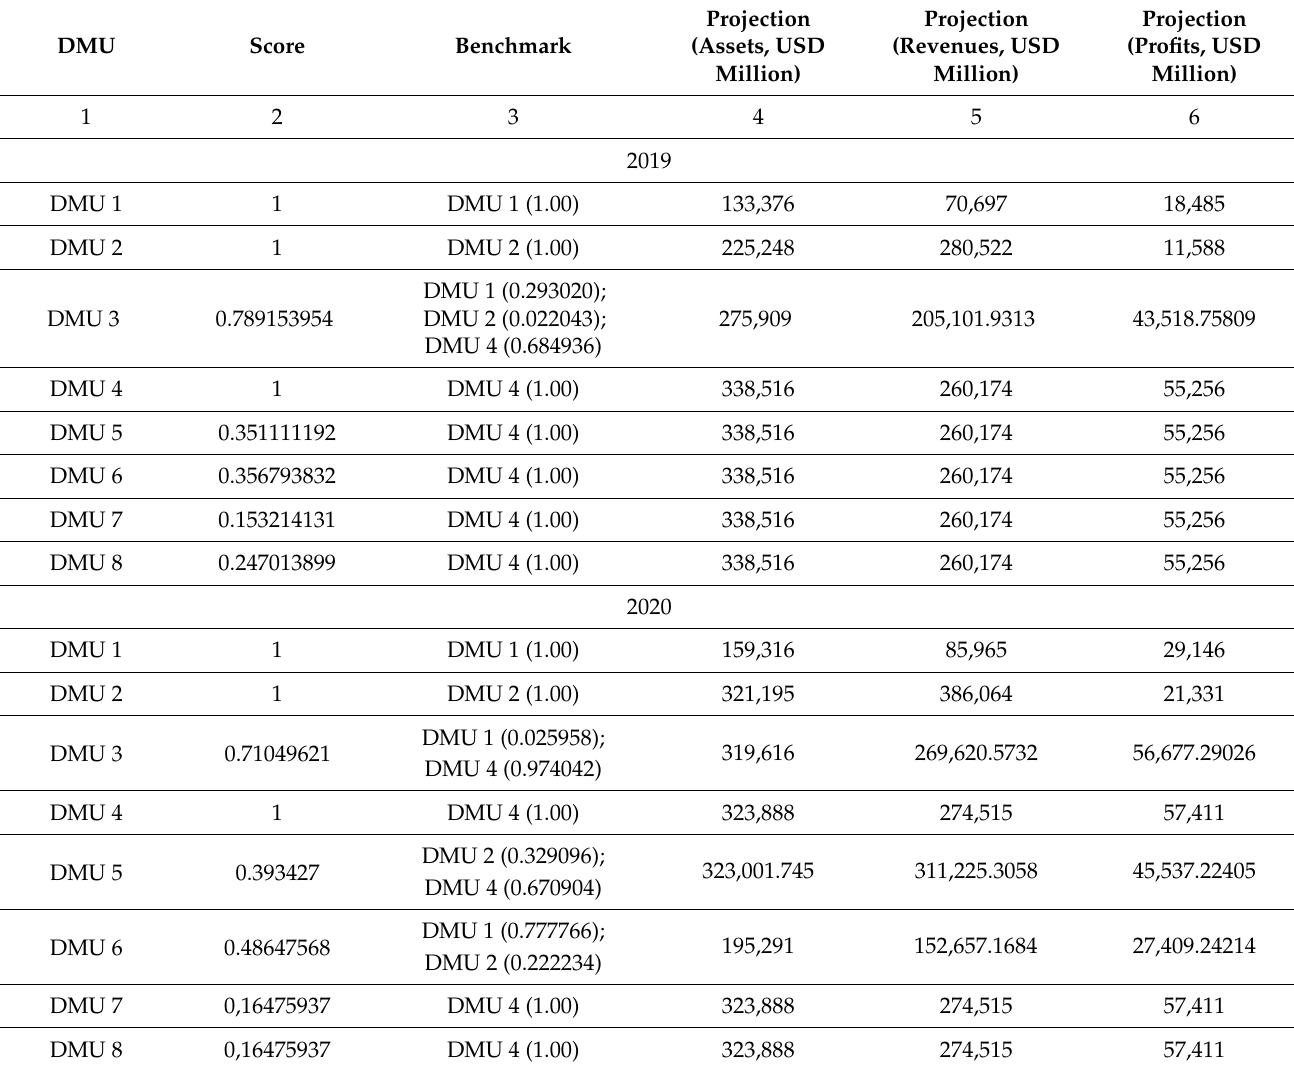
Table 3. Envelopment model output-oriented results for 2019–2021